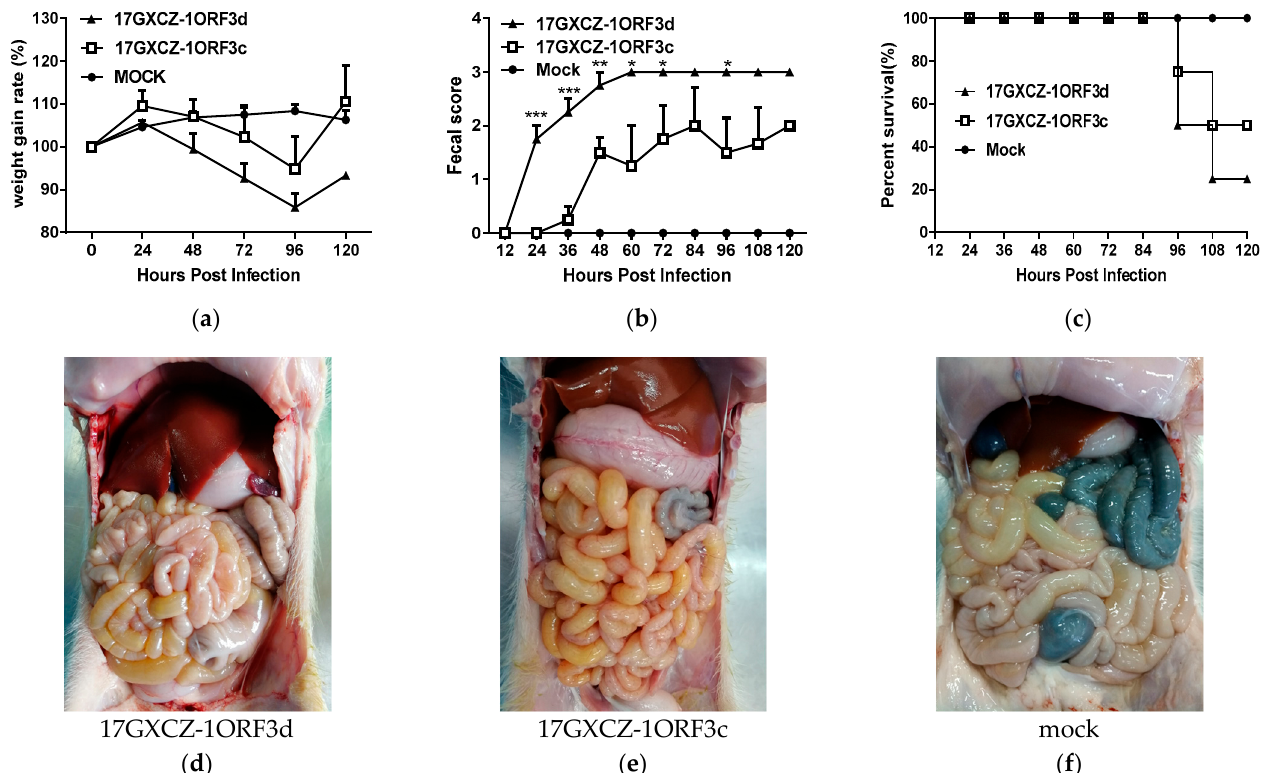
Figure 4. Pathogenicity analysis of the PEDV strains 17GXCZ-1ORF3d and 17GXCZ-1ORF3c. ( a ) The average body weight changes in each group. ( b ) Fecal scores of piglets in different groups. Rectal swabs were collected at different timepoints after PEDV infection, scores standard: 0, normal; 1, pasty stool; 2, semiliquid diarrhea; and 3, liquid diarrhea. ( c ) The survival rate of piglets in each group. After oral inoculation with PEDV, one piglet died at 96 hpi and one at 108 hpi in the 17GXCZ-1ORF3c group, while two piglets died at 96 hpi and one piglet died at 108 hpi in the 17GXCZ-1ORF3d group. Each data point in the graph represents the average value from four or all of the surviving animals ± SEM. The asterisks indicate significant differences between the groups of 17GXCZ-1ORF3d and 17GXCZ-1ORF3c (* p < 0.05; ** p < 0. 01; *** p < 0 .001). Gross lesions found in piglets of ( d ) 17GXCZ-1ORF3d, ( e ) 17GXCZ-1ORF3c and ( f ) mock groups at necropsy. The piglets were necropsied upon death, whereas all surviving piglets from the challenged and mock groups were euthanized at 5 dpi for post-mortem examinations.